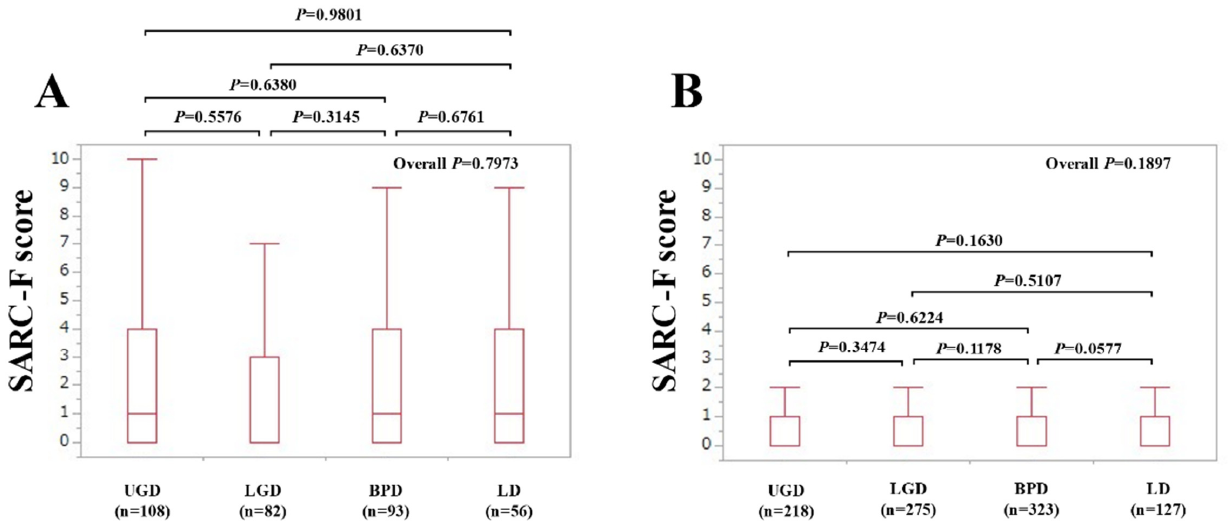
Figure 4. ( A ) SARC-F scores according to the diseases (UGD, LGD, BPD, and LD) in patients with advanced cancer ( n = 339). ( B ) SARC-F scores according to the diseases (UGD, LGD, BPD, and LD) in patients without advanced cancer ( n = 943).